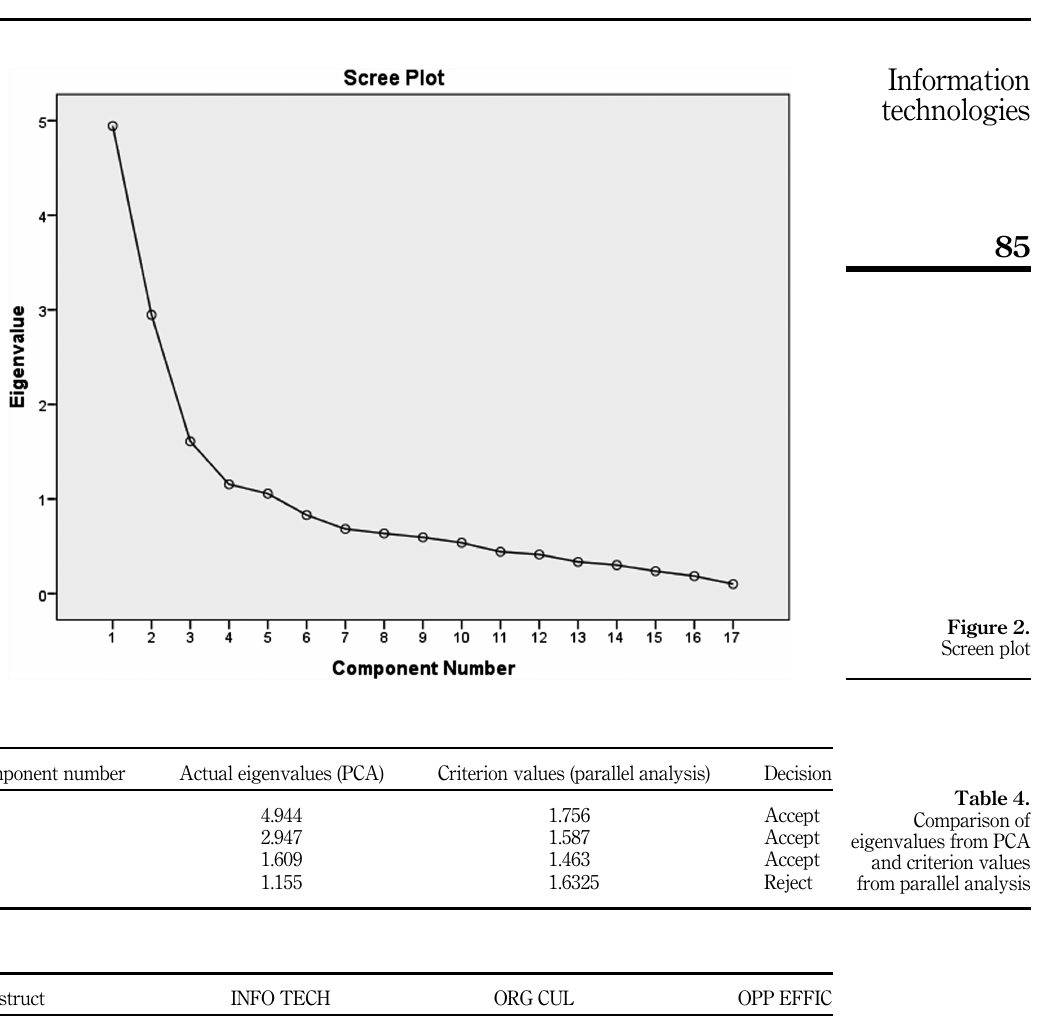
Table 5. Discriminant